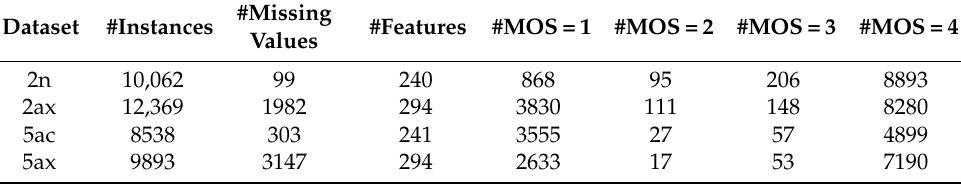
Table 1. Characteristics of datasets produced in this study.